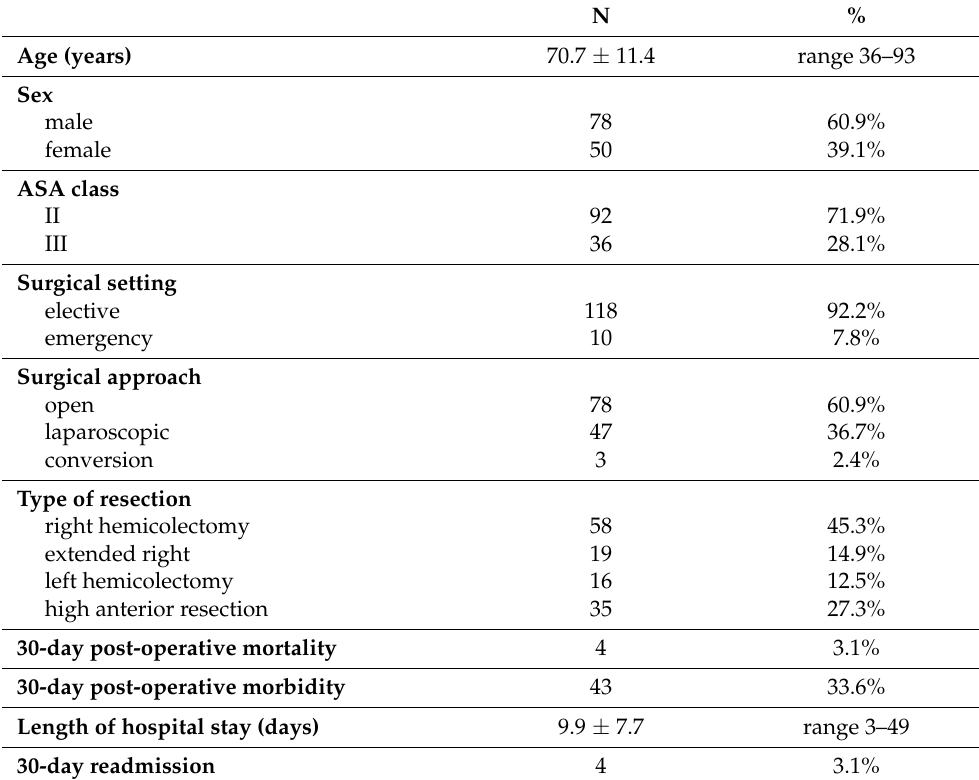
Table 1. Demographic and operative